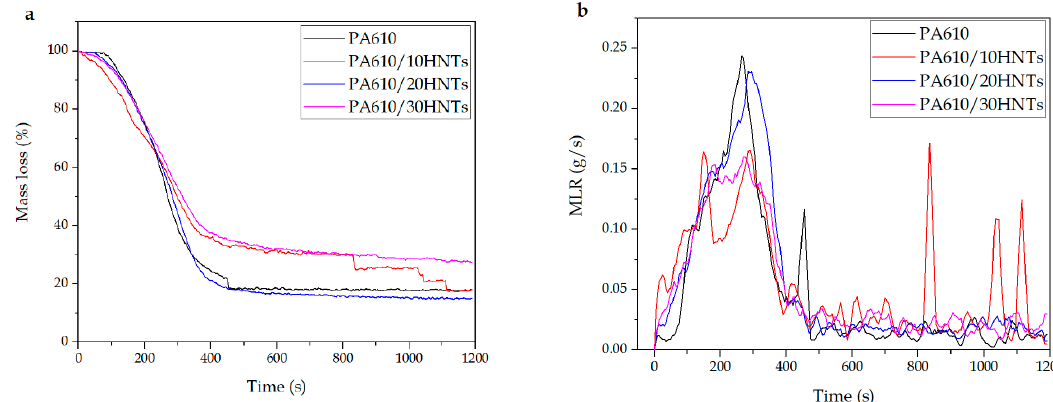
Figure 7. ( a ) Percentage of residual mass during the testing of PA610 samples with HNTs; ( b ) Loss of mass ratio of PA610 samples with HNTs.